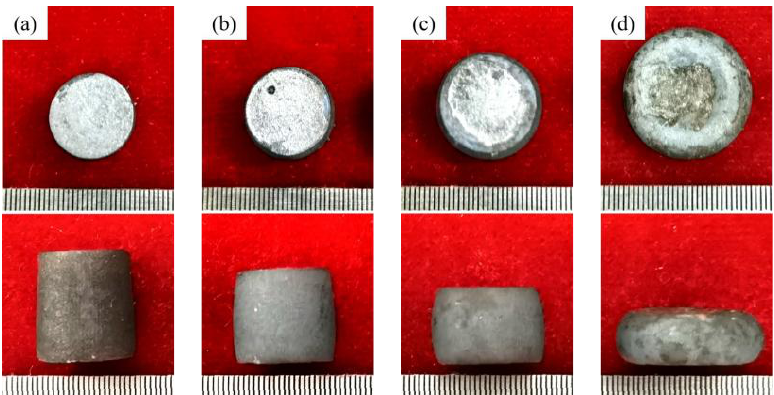
Figure 5. The morphology of the thermal compression samples: ( a ) 15%; ( b ) 30%; ( c ) 45%; ( d ) 60%.